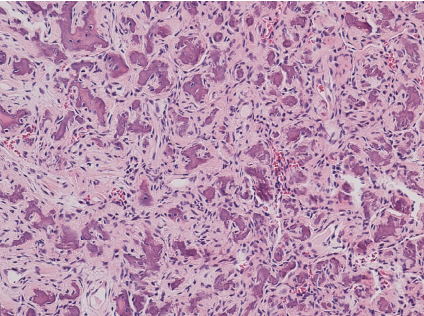
Figure 5: Histologic imaging of gross specimen. Histopathology of the tumor comprised numerous small, round ossicles embedded in cellular fibrous stroma, and occasional osteoclast-like giant cells are identified. The lesion is well demarcated from the surrounding bone. No increased mitotic figures or necrosis is seen. Benign fibro- osseous lesion, consistent with ossifying fibroma of the jaw (he- matoxylin and eosin,